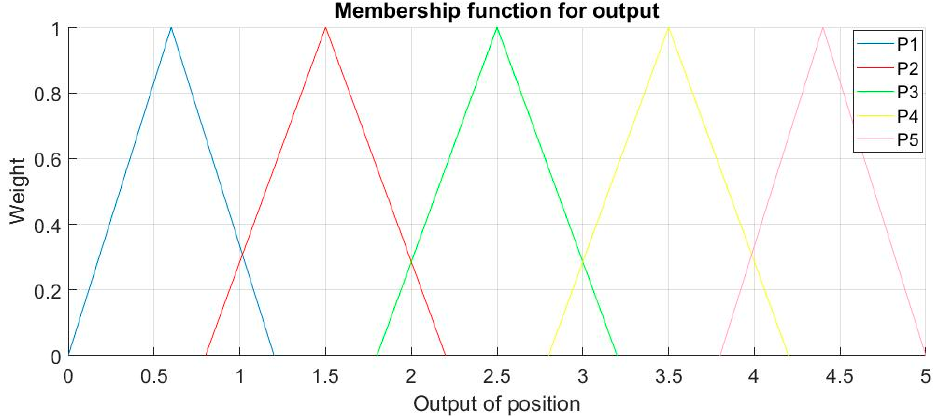
Figure 7. Membership Functions for Output P.